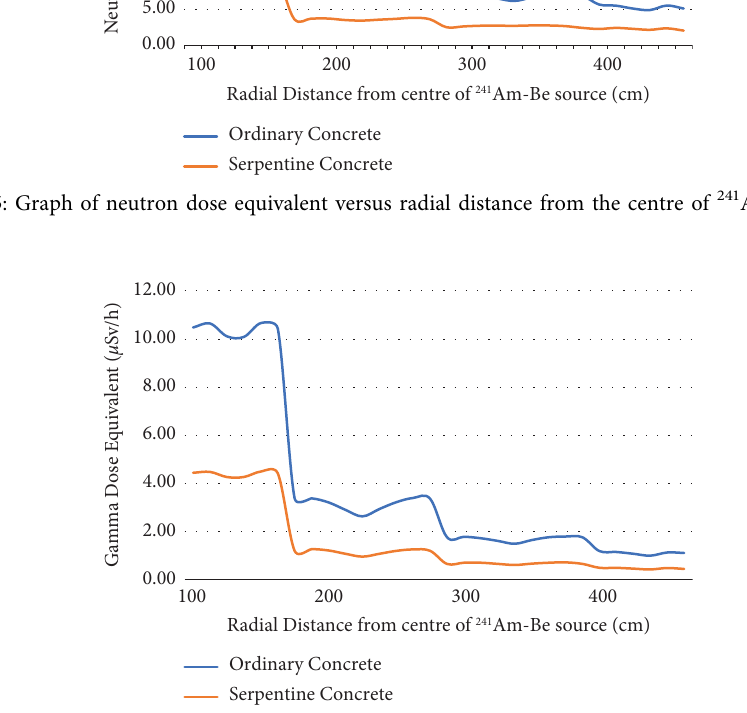
Figure 6: Graph of gamma dose equivalent versus radial distance from the centre of 241 Am-Be Table 2: Ratio of average neutron dose equivalent of serpentine concrete to ordinary concrete. Distance